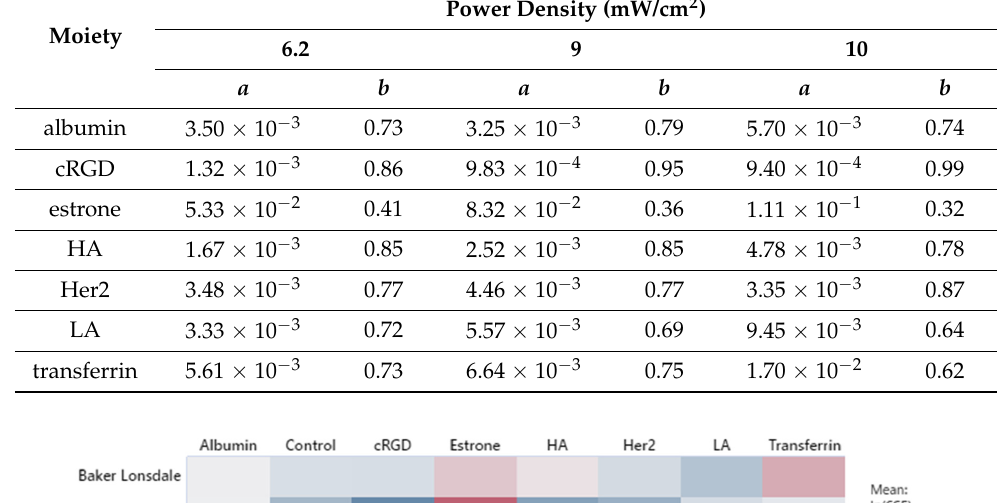
Table 4. Korsmeyer–Peppas model coefficients a and b at 20 kHz.